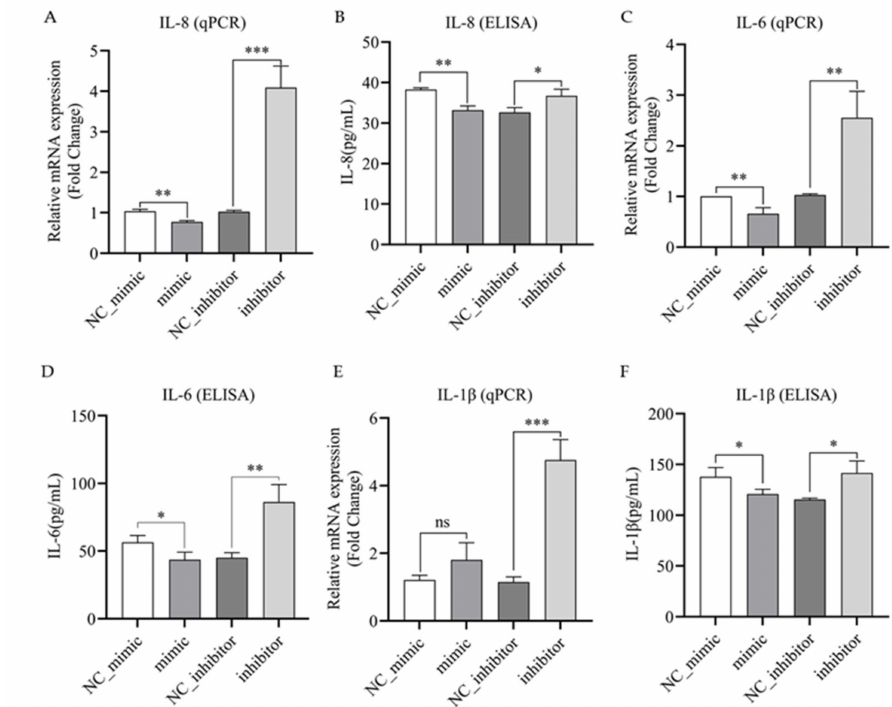
Figure 5. Bta-miR-223 inhibits the production of IL-1 β , IL-8 and IL-6 in bMECs. The bMECs were transfected with bta-miR-223 mimic or negative control (NC_mimic) and bta-miR-223 inhibitor or negative control (NC_inhibitor). bMECs were stimulated with LPS for 6 h. Then the cells were collected, and the expression levels of IL-8 ( A , B ), IL-6 ( C , D ) and IL-1 β ( E , F ) mRNA and secretion levels of inflammatory factors were detected. qPCR and ELISA were used to detect the expression of inflammatory factors in each group of cells at the mRNA and secretory levels, respectively. The experimental results are displayed as the mean ± SEM. ns p > 0.05, * p < 0.05, ** p < 0.01, *** p <